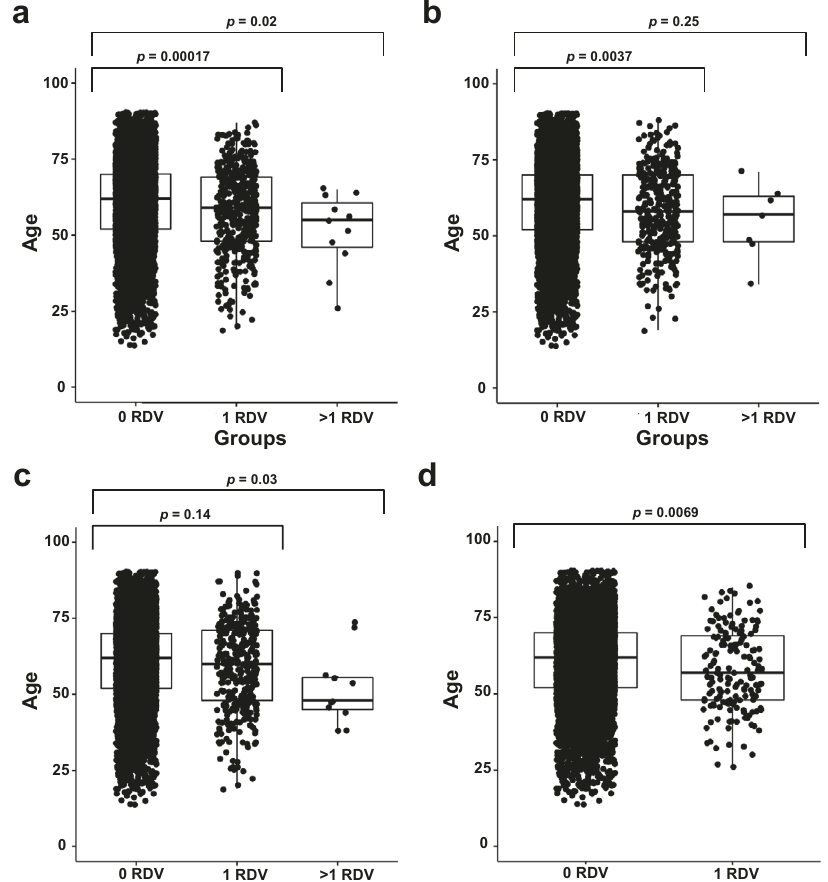
Fig. 5 Comparison of age of diagnosis based on germline RDV load in TCGA cases. a Cancer predisposition genes b DNA damage repair genes c Somatic cancer driver genes d Fanconi Anemia genes. p -values are calculated based on Mann – Whitney U -test. Boxplot elements: center line indicates median; box limits represent lower (25th percentile) and upper (75th percentile) quartiles; whiskers extend to 1.5 times the interquartile